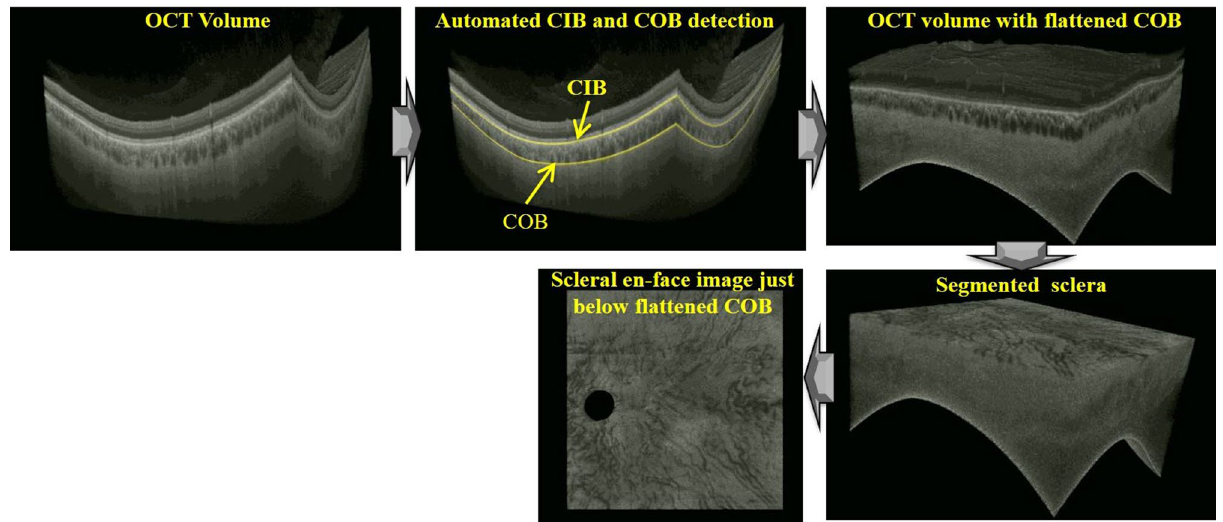
Figure 5. End-to-end depiction of automated extraction of volume below the sclera-choroid interface scans based on the representative wide-field optical coherence tomography (OCT)